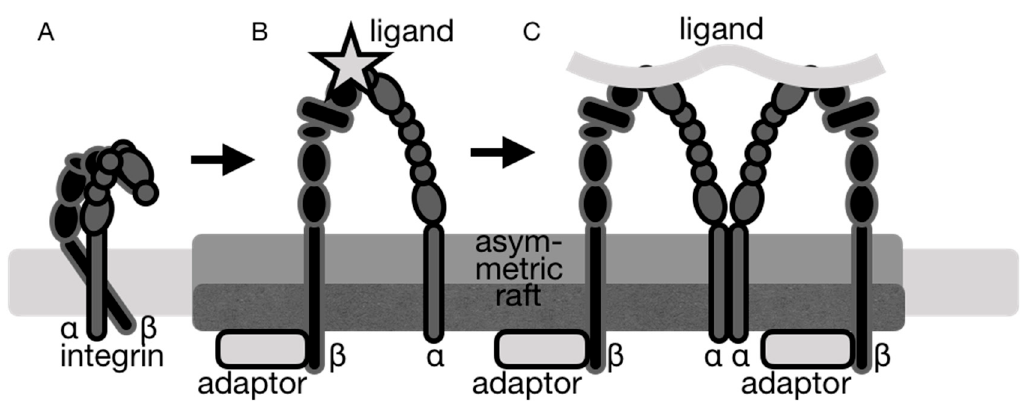
Figure 3. Integrin adhesion and signaling are linked to the recruitment of integrins to lipid rafts. Several integrins have been found in lipid rafts, whereby the activated form of integrin preferably localizes to cholesterol-enriched lipid rafts. The cholesterol-rich membrane domains cluster integrin at focal adhesions, which regulates integrin activation. ( A ) , inactive integrin localized to non-raft regions of the plasma membrane. ( B ), activated integrin localizes to lipid rafts. ( C ), integrin clustering at focal adhesions in lipid rafts.